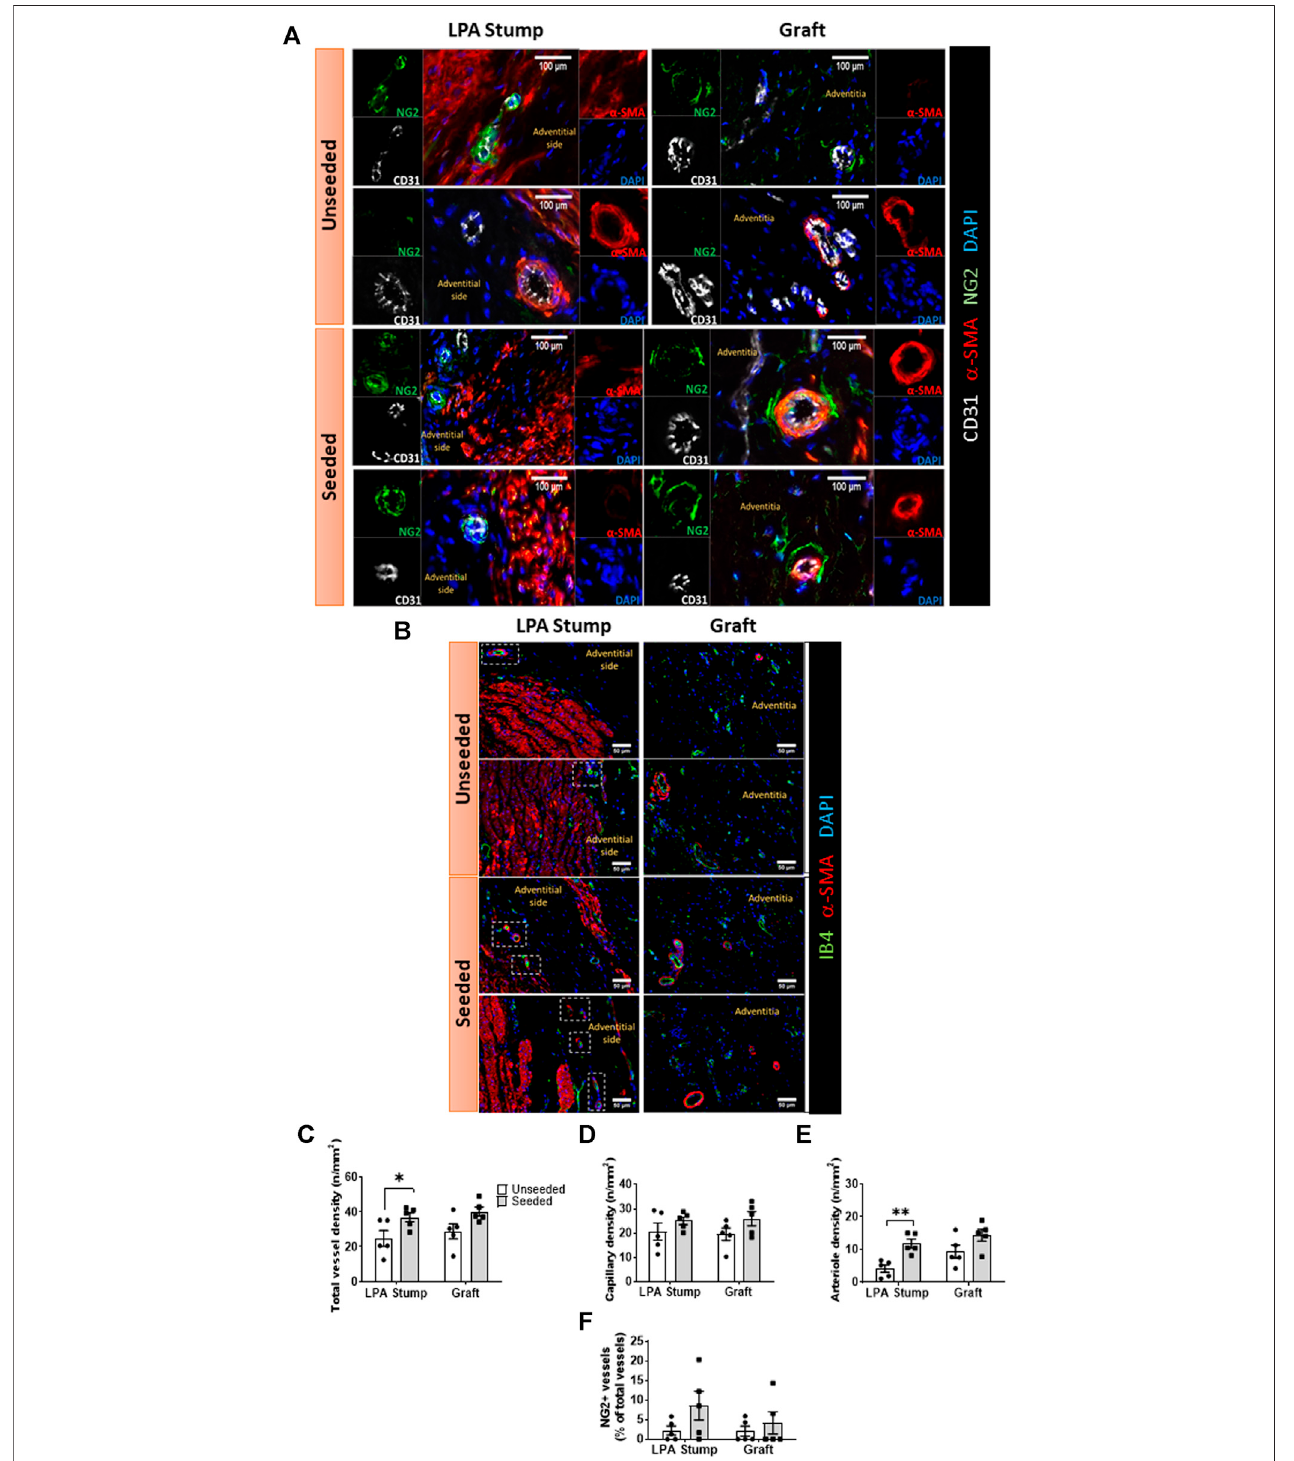
FIGURE4| Microvascularcompositionoftheimplantedartery. (A,B) Immuno fl uorescentmicroscopyimageofthevascularizationattheleveloftheLPAstumpand grafts. In panel A, endothelial cells were stained with CD31 (white), vascular smooth muscle cells with a-SMA (red), pericytes with NG2 (green), and nuclei with DAPI (blue).InpanelB,endothelialcellsstainedwithIB4(green),vascularsmoothmusclecellswith α -SMA(red),and nucleiwithDAPI(blue).Thelocationoftheneo-adventitia is indicated in each image. Vascular smooth muscle cells are visualized in the tunica media of the LPA stump, the graft structure, and within intraparietal arterioles. (C – F) Bar graphs showing the vascular density and pericyte coverage in the two groups at the level of the LPA stump and grafts (C) Total vascular density, (D) Capillary density, (E) arteriole density, (F) NG2+ percentage. N (cid:1) 5 biological replicates per experimental group. Data are expressed as mean ± SEM. * p < 0.05, ** p < 0.01.